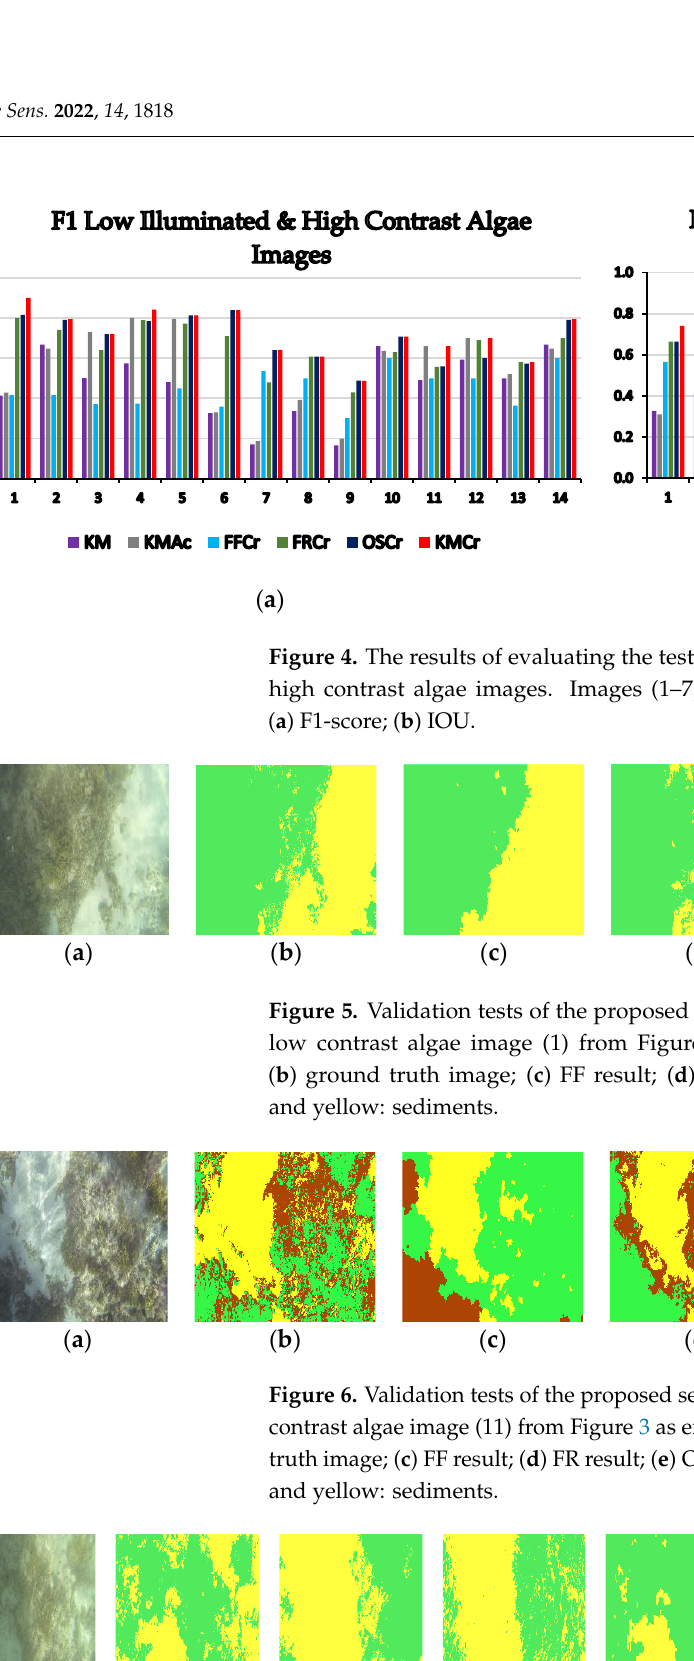
Figure 7. Validation tests of the proposed segmentation algorithms using low illuminated and high contrast algae image (1) from Figure 4 as example of two categories: ( a ) original image; ( b ) ground truth image; ( c ) KM result; ( d ) KMAc result; ( e ) FFCr result; ( f ) FRCr result; ( g ) OSCr result; ( h ) KMCr result. Green: algae and yellow: sediments.